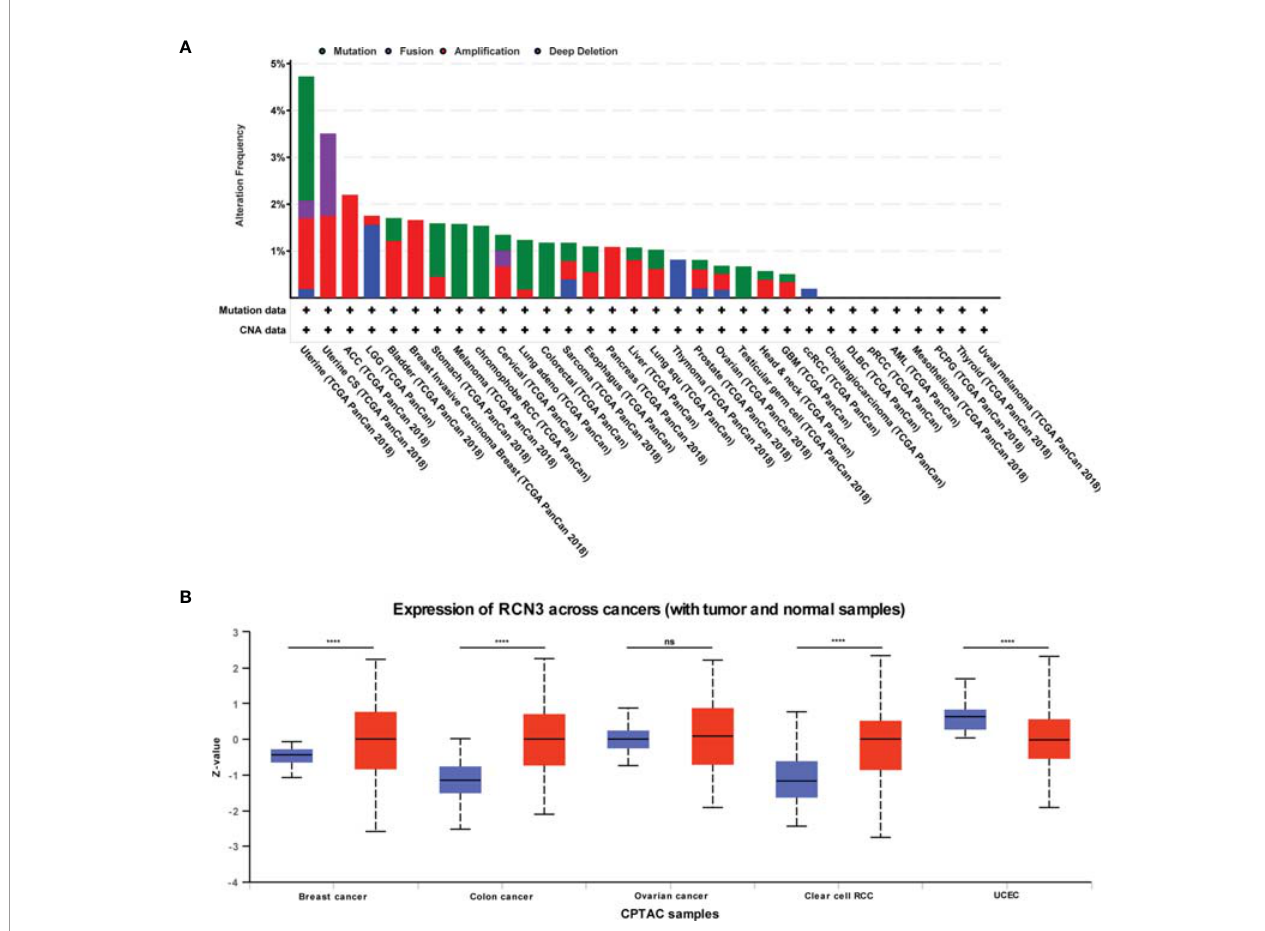
FIGURE 3 | CNA and total protein expression levels of RCN3 in human cancers. (A) CNA and mutation frequency data of RCN3 for the TCGA tumors were accessed using the cBioPortal tool. (B) The expression of the RCN3 total protein between normal samples and tumor samples of breast cancer, colon cancer, ovarian cancer, clear cell RCC, and UCEC were determined by UALCAN. ****p < 0.0001; ns, no signi fi